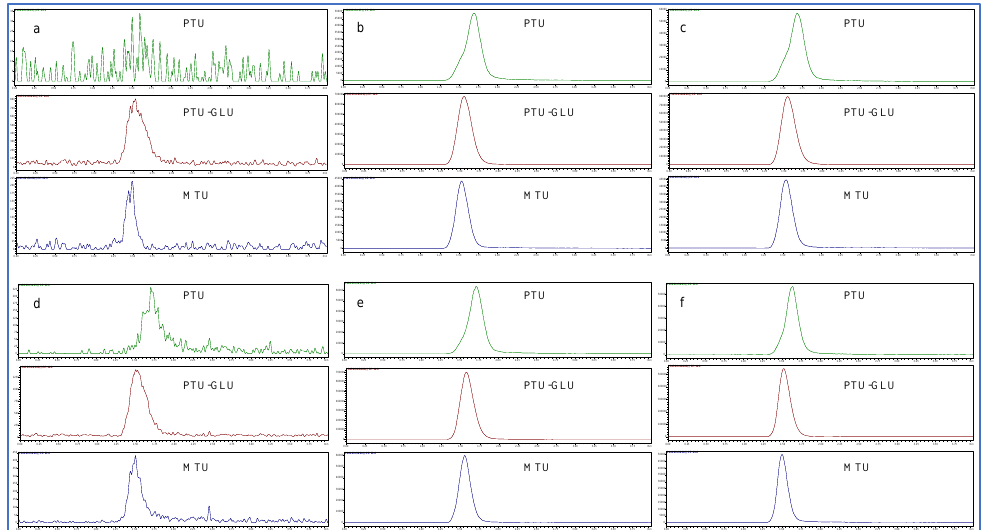
Figure 4. Representative chromatograms of HLMs and human recombinant UGT1A9 spiked with PTU (0.1 µ M), PTU-GLU (0.1 µ M) and MTU (IS, 10 µ M). ( a ) blank HLMs; ( b ) inactive HLMs spiked with PTU, PTU-GLU and IS; ( c ) inactive HLMs spiked with PTU, PTU-GLU, IS and UGT1A9 inhibitor magnolol (50 µ M); ( d ) blank human recombinant UGT1A9; ( e ) inactive human recombinant UGT1A9 with PTU, PTU-GLU and IS; ( f ) inactive human recombinant UGT1A9 spiked with PTU, PTU-GLU, IS and UGT1A9 inhibitor magnolol (50 µ M).